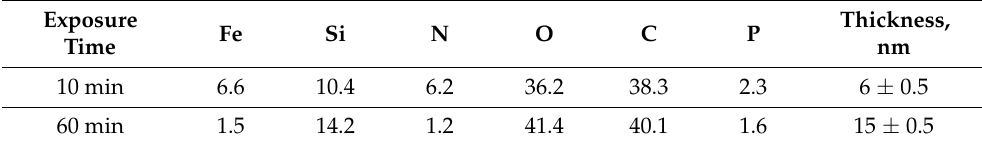
Table 5. Chemical composition of the protective layer on steel after holding in a dispersion of the